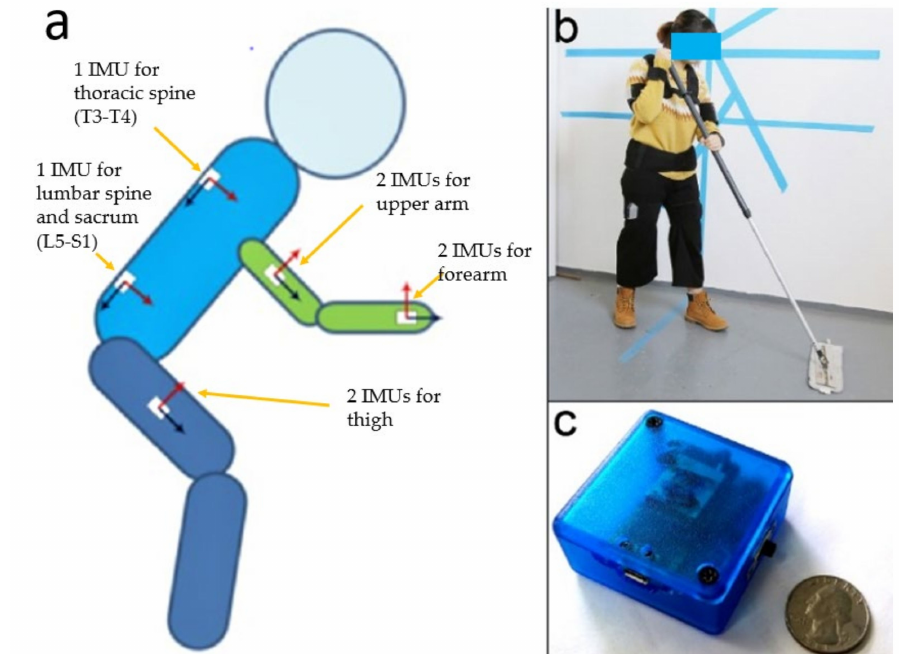
Figure 3. Wearable vest for occupational physical activities: ( a ) wearable track device and location of IMUs and their orientations (orientations were displayed as two orthogonal vectors), ( b ) performing manual material handling tasks with prototype, ( c ) IMU used in this